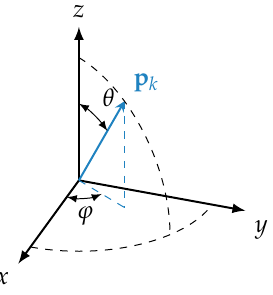
Figure 5. Definition of the orientation vector p k by spherical